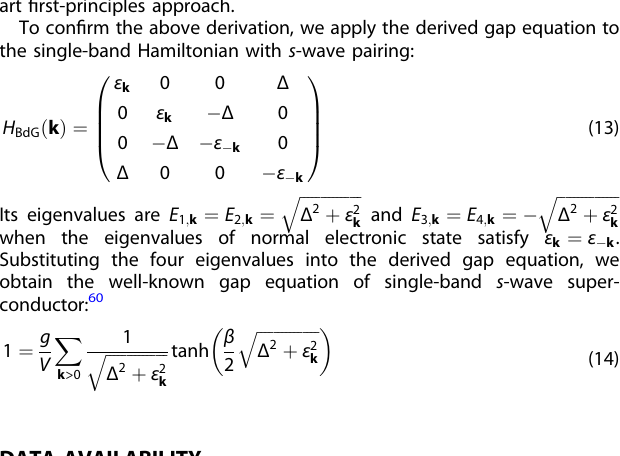
All data needed to evaluate the conclusions of this paper are available within the paper and Supplementary